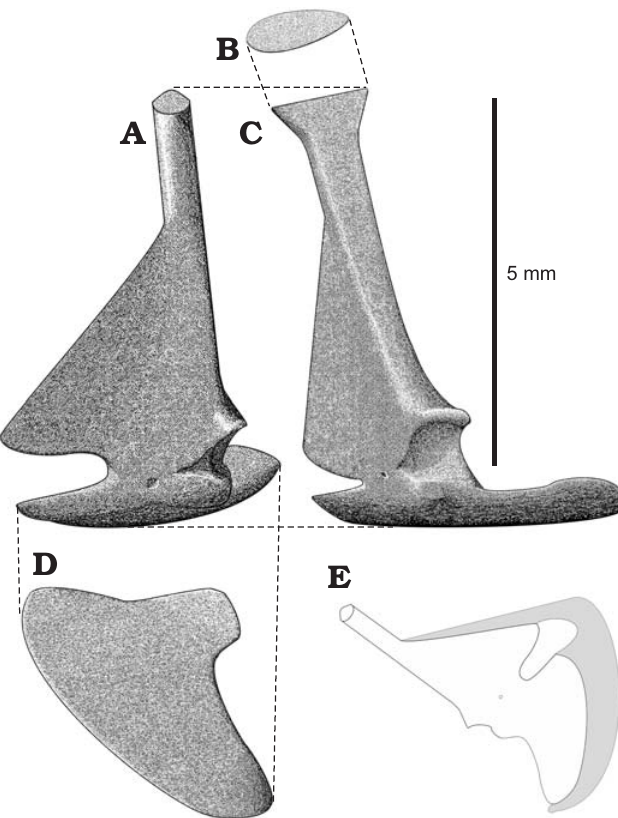
Fig. 3. Reconstruction of scapulocoracoid of Slavoia darevskii based on different specimens, in anterior ( A ), dorsal ( B ), lateral ( C ), and ventral ( D ) views. E . Reconstruction of epicoracoid assuming that it did not reach the